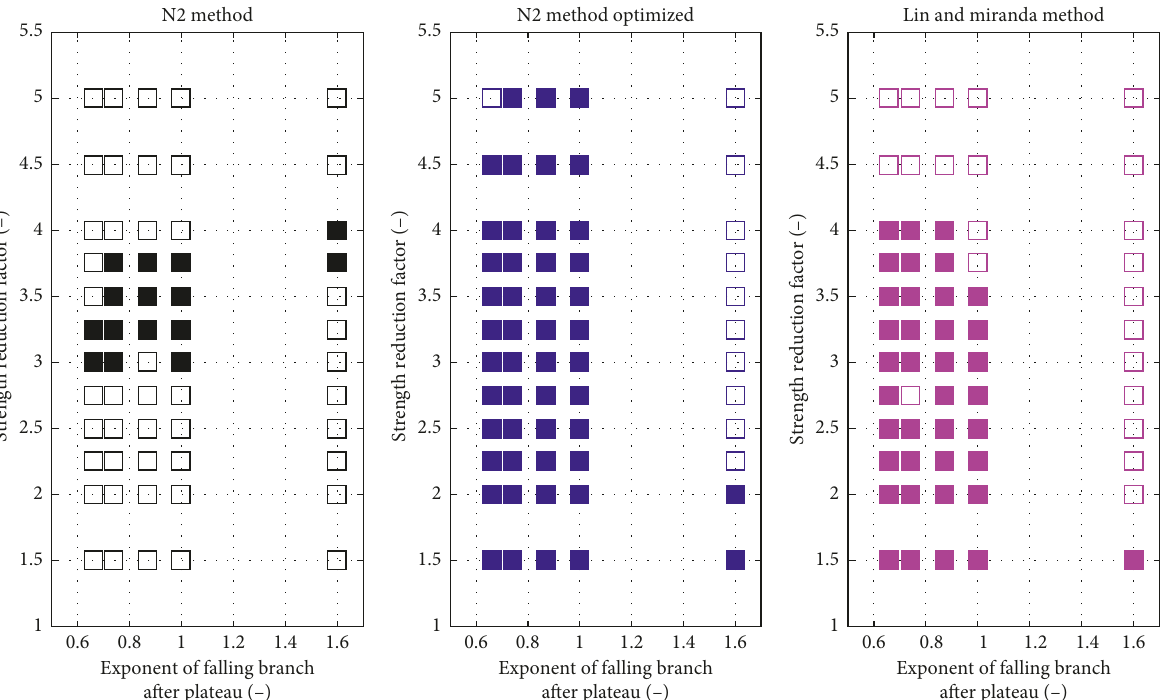
Figure 14: Accuracy assessment of the 3 investigated methods for soil class C with respect to the exponent of the decreasing branch after the plateau of the response spectrum. Pixel coordinates correspond to strength reduction factor values ( R ) and exponent of the decreasing branch ( α ). Pixels are full if the method is accurate for the corresponding couple of values ( R , α